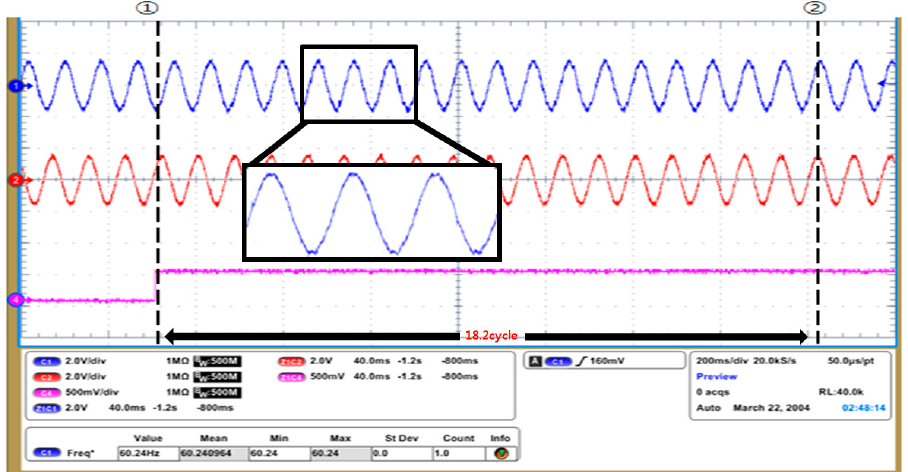
Figure 23. Experimental results in Case IV. (SBGS ⟶ GS Mode) (From top to bottom: Measured a -phase inverter output voltage and grid voltage (200 V/div), and status signal (0 or 1)), ( ① : starting point of synchronization. ② : finalized point of synchronization).